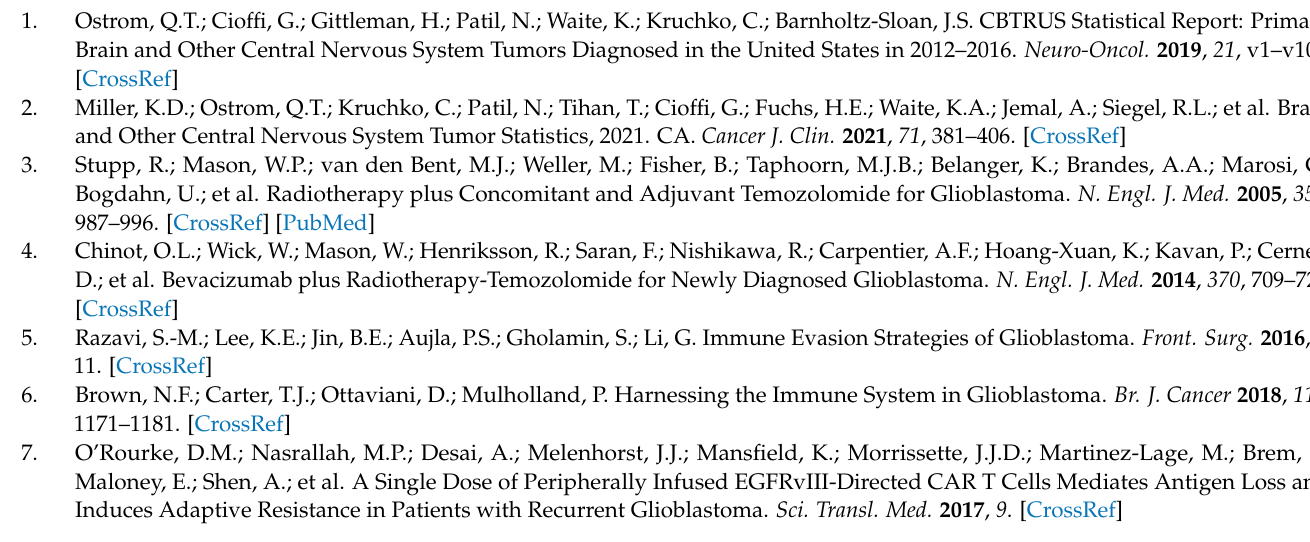
CD86, and (i) CD40 in the human U87 GBM cell line both before and following PTT with aFn14-PBNP at various laser powers; Figure S5: Flow cytometry histograms and dot plots of expression of the above markers in the human U251 GBM cell line; Figure S6. PTT using aFn14-PBNP triggers thermal and immunogenic cell death in a manner similar to PBNPs in U87 tumor cells, (a) viability, (b,c) MHC expression, (d) tumor specific antigen expression (e,f) immune checkpoint inhibitor expression, (g–j) T cell costimulatory markers; Figure S7: Determination of the concentration of aFn14-PBNP needed for the targeted PTT assay. (a) Schematic. (b,c) Heating curves (b) and the corresponding thermal doses administered (c) to U251 after incubation with various concentrations of aFn14-PBNPs during PTT. (d,e) Heating curves (d) and corresponding thermal doses administered (e) to U251